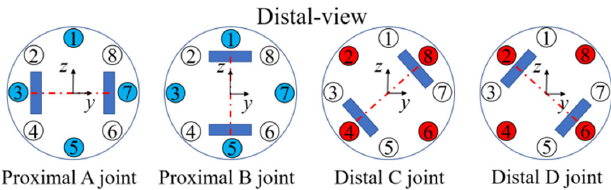
Figure 9. Distal section views of robotic arm and wire